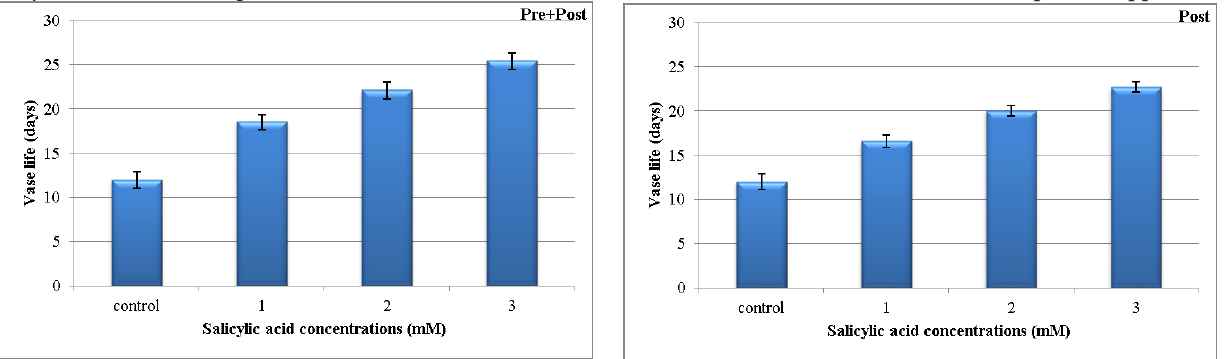
Fig. 6. Effect of pre + post-harvest and post-harvest applications of different concentrations of salicylic acid on vase life (days) of cut alstroemeria flowers in experiment. The results represent the means of 12 cut flowers in 4 replicates ± standard